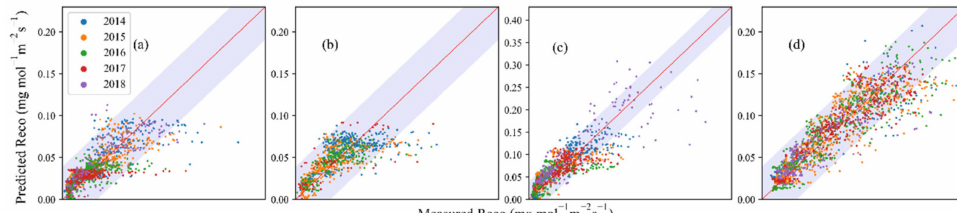
Figure 7. Performance of time series model at four study sites in different years. ( a – d ) is for SHB, DRY, TEMP, and MDW,